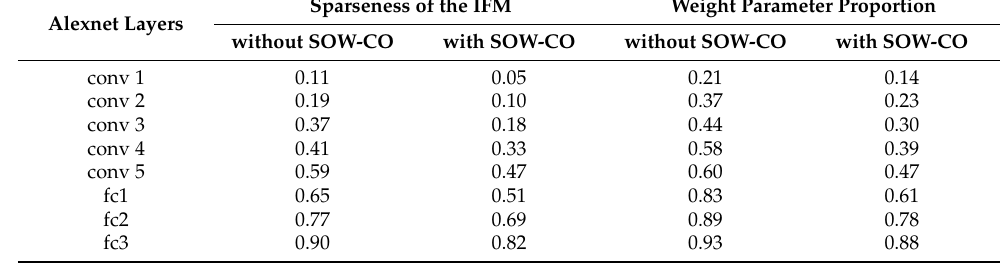
Table 5. Analysis of sparseness of the IFM and weight parameter proportion for Alexnet.